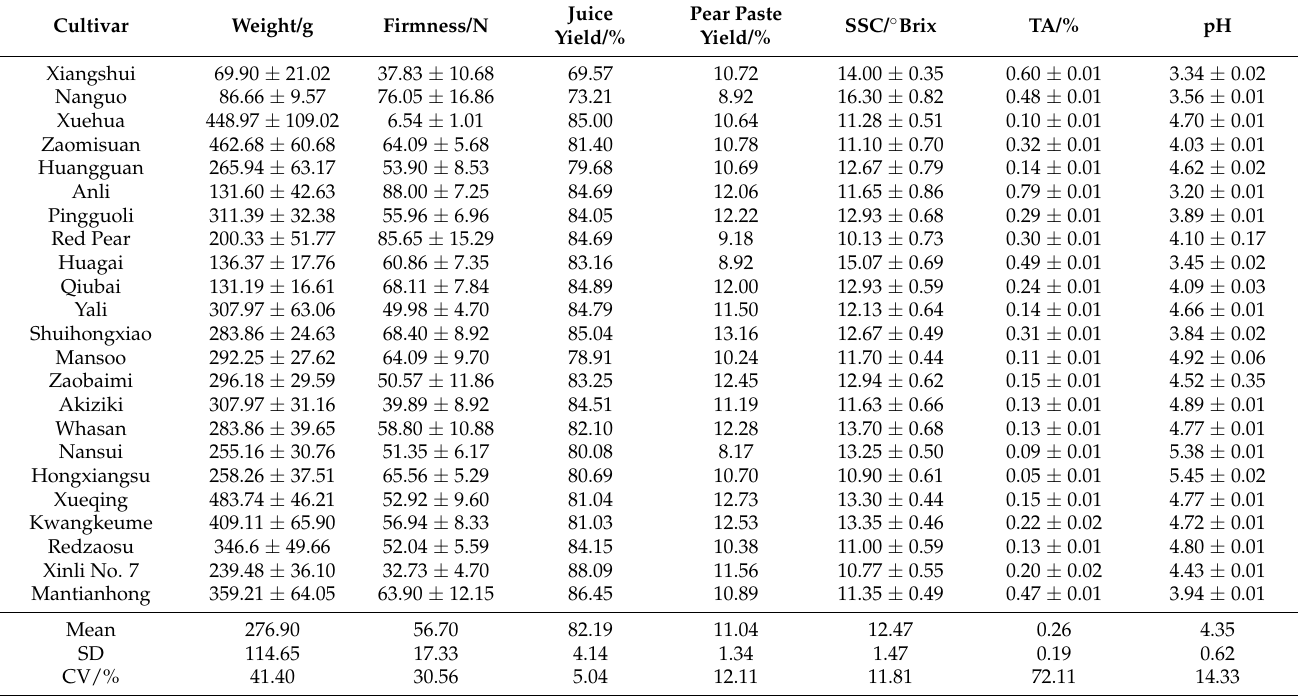
Table 1. Physicochemical properties of different cultivars of pear